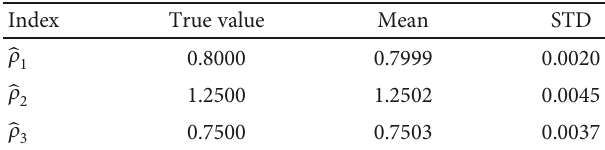
Table 1: Performance of gain and phase estimation. (a) Gain estimation results of γ